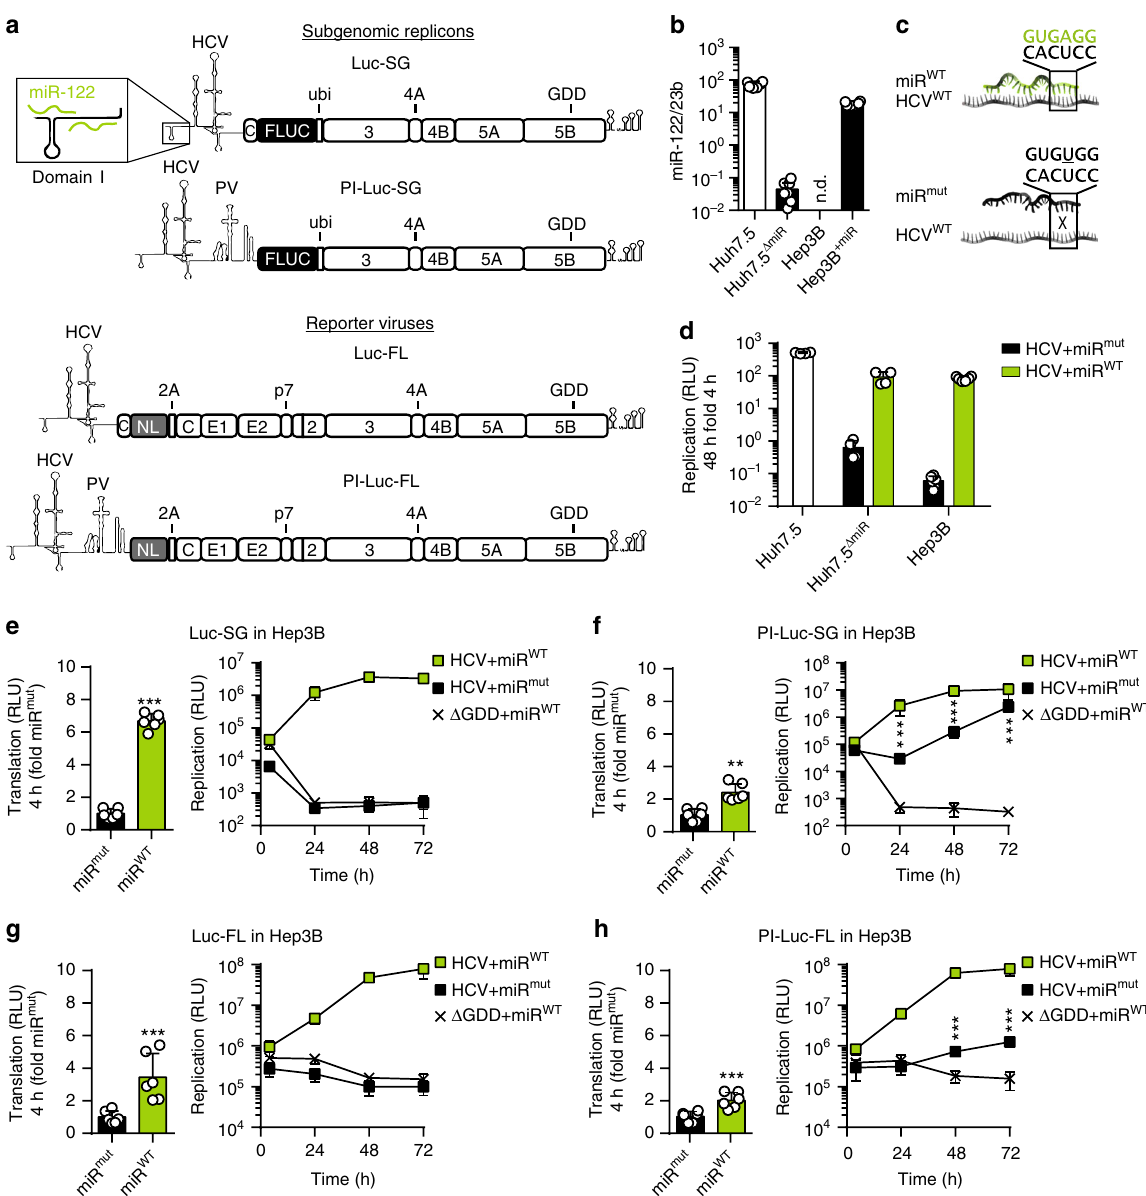
Fig. 1 Initial translation and its importance for the HCV life cycle. a Representation of replicons and full-length viruses used in this study (FLUC fi re fl y luciferase, NL nano luciferase). 5 ′ UTR/IRES elements are indicated. The box shows an enlarged schematic of the miR-122-binding sites in the 5 ′ UTR. b Quanti fi cation of mature miR-122 by stem-loop qRT-PCR in naïve Huh7.5 cells, a Huh7.5 miR-122 knock-out cell clone (Huh7.5 Δ miR ), Hep3B cells before (Hep3B), and after (Hep3B + miR ) electroporation of miR-122 mimic. All values were normalized to miR-23b levels, which is homogenously expressed in hepatic cells. c Binding of wild type miR-122 (miR WT ) to a target RNA (HCV WT ) and in fl uence of seed mutations (miR mut ). d Comparison of HCV replication in different cell lines by luciferase assay after co-electroporation of reporter replicons (Luc-SG) and miR WT or miR mut into Hep3B cells. Reporter activity was measured at 4 and 48 h. e Luciferase assay of initial translation (left panel) and replication (right panel) of subgenomic HCV. f Luciferase assay to determine the effects of PV IRES-driven polyprotein translation on the viral life cycle (PI-Luc-SG). g , h Con fi rmation of results from ( e ) and ( f ), using full length reporter viruses (Luc-FL, PI-Luc-FL). n.d. not detectable. Mean values (±SD), n = 3, in technical duplicates. RLU relative light units, Δ GDD replication de fi cient mutant. For translation, statistical signi fi cance was determined for miR WT against miR mut ; for replication HCV + miR mut was tested against Δ GDD. * P <0.05, ** P <0.01, * P